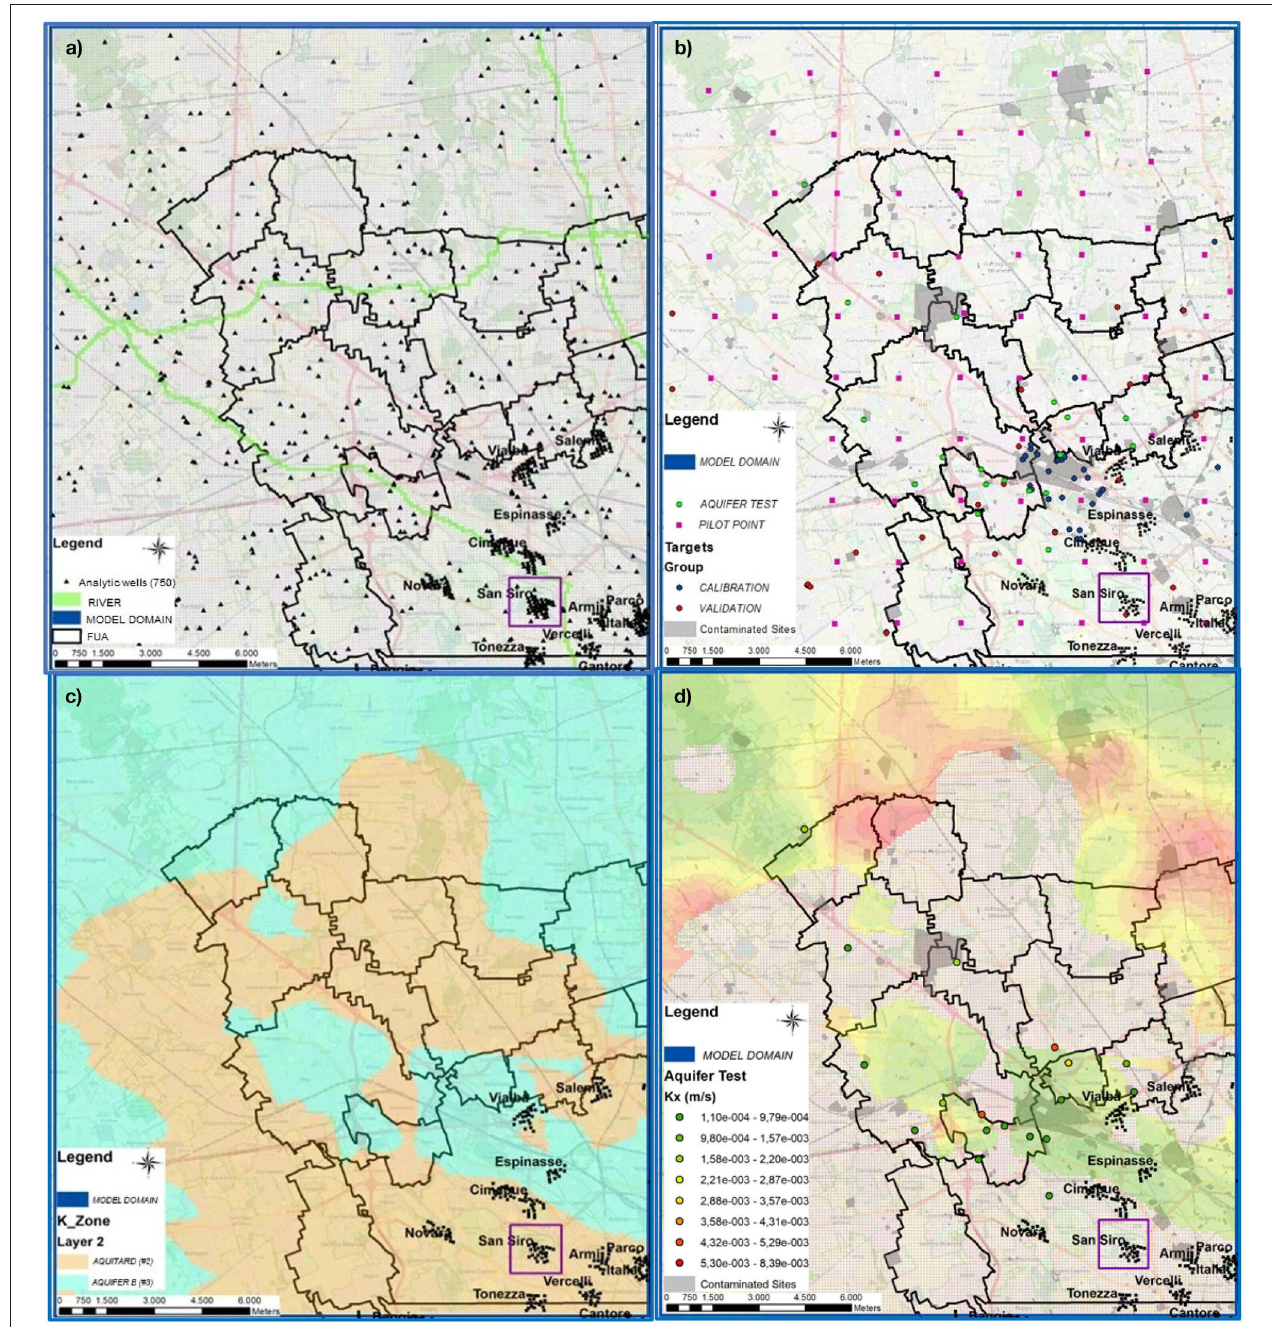
FIGURE 2 | Groundwater model: (a) boundary conditions, grid, and internal condition; (b) Pilot Point (PP) positions and targets used for calibration (blue) and validation (red); (c) example of different zones used in calibration process for Layer 2 and (d) calibrated hydraulic conductivity distribution for Layer 2 in the deterministic process. The violet squared area is the San Siro pumping station, where the particles are located for the backtracking analysis.